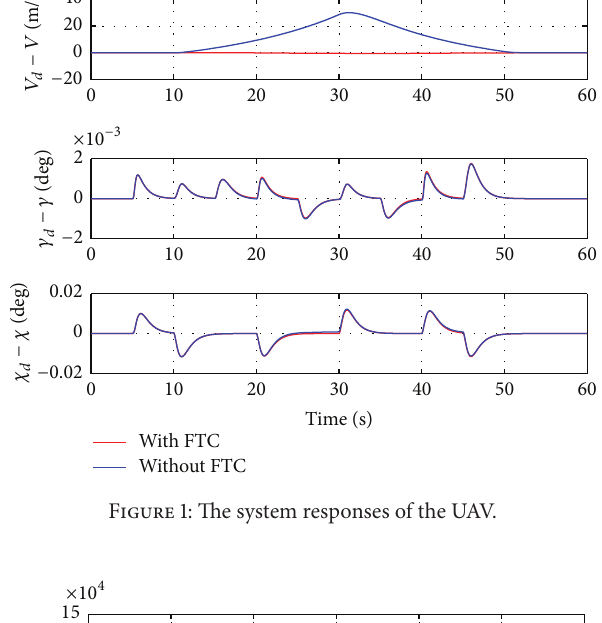
Table 1: UAV model parameters.